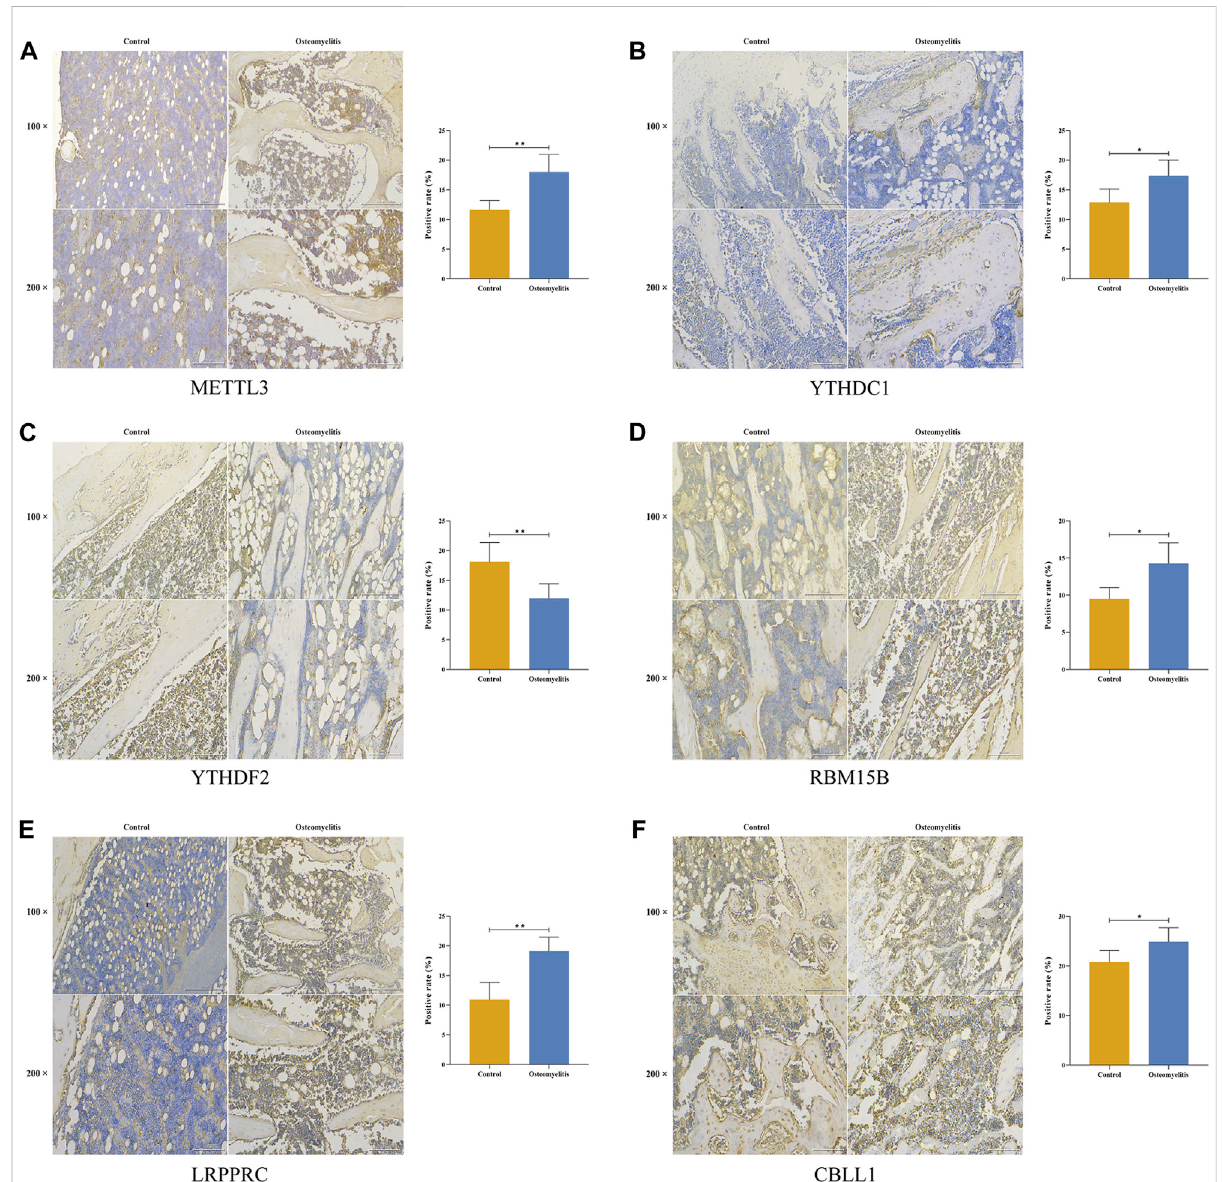
FIGURE 11 Immunohistochemistry of 6 signi fi cant m6A regulators in the focal bone tissue and healthy bone tissue of rat model of osteomyelitis. METTL3 (A) ,YTHDC1 (B) ,YTHDF2 (C) ,RBM15B (D) ,LRPPRC (E) ,andCBLL1 (F) wereabundantlyexpressedinfocalbonetissues,andthepositiverates were signi fi cantly higher than that of healthy bone